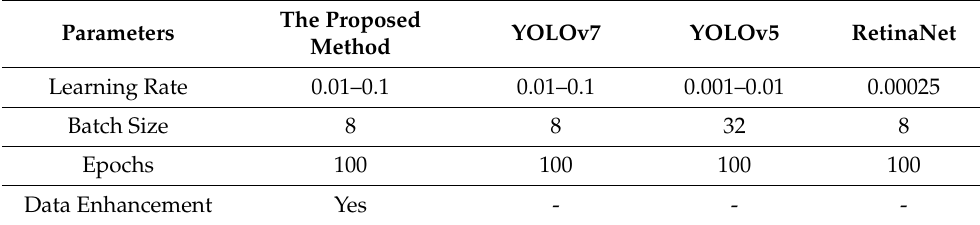
Table 2. Details of the parameters of the model trained.